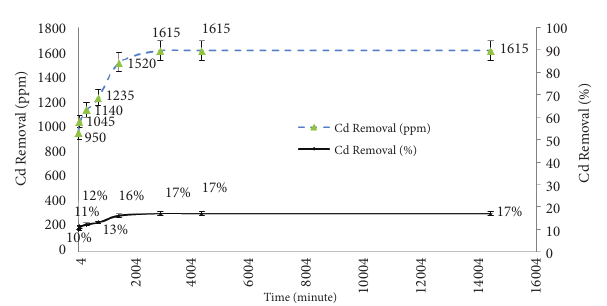
Figure 6. Removal of Cd by nanofluid at different Contact Time (Concentration = 500 ppm, pH = 6.5, ratio of soil mass (gr) to nanofluid volume (mL) = 1:10)